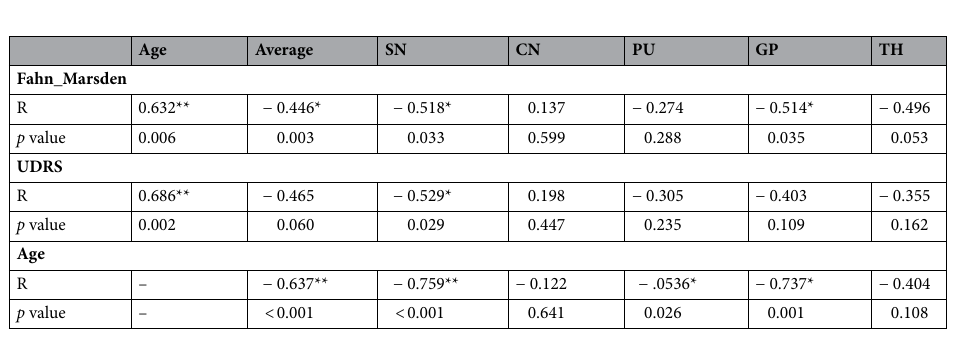
Table 4. The correlation between dystonia feature, age and contrast ratio of deep gray matter regions in patients with RTT. CTL control, Average average values of SN, PU and GP, SN substantia nigra, CN caudate nucleus, PU putamen, GP globus pallidus, TH thalamus, UDRS Unified Dystonia Rating Scale. * p < 0.05, ** p < 0.01. Adjusted for multiple comparison with Benjamini–Hochberg